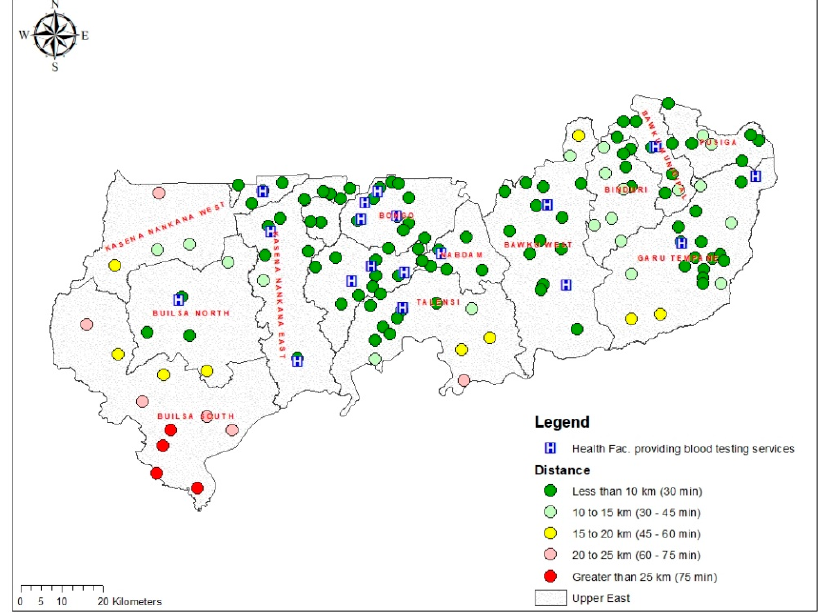
Figure 6. Map showing the distribution of distance (km) and travel time (minutes) from towns to health facilities providing blood group and rhesus type testing services in the UER.